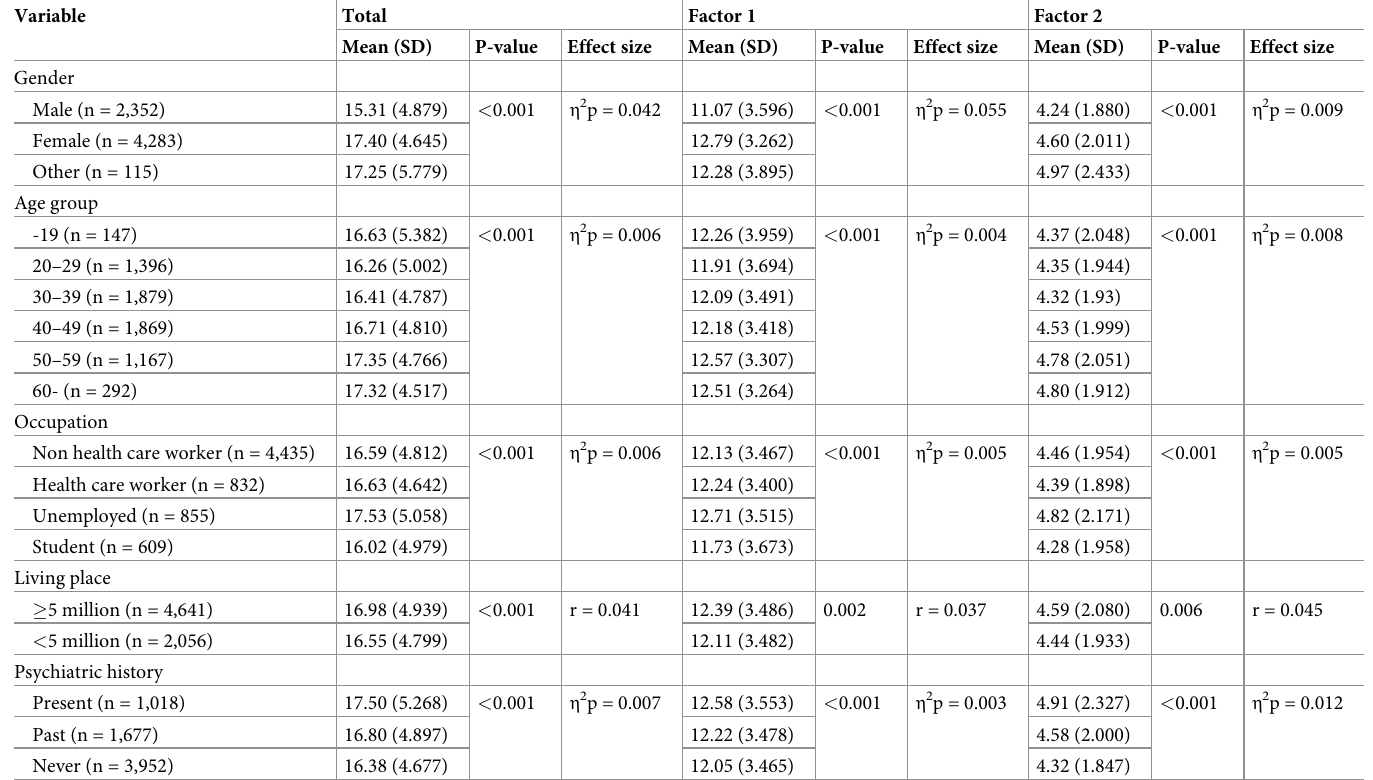
Table 5. Association between FCV-19S score and socio-demographic factors.